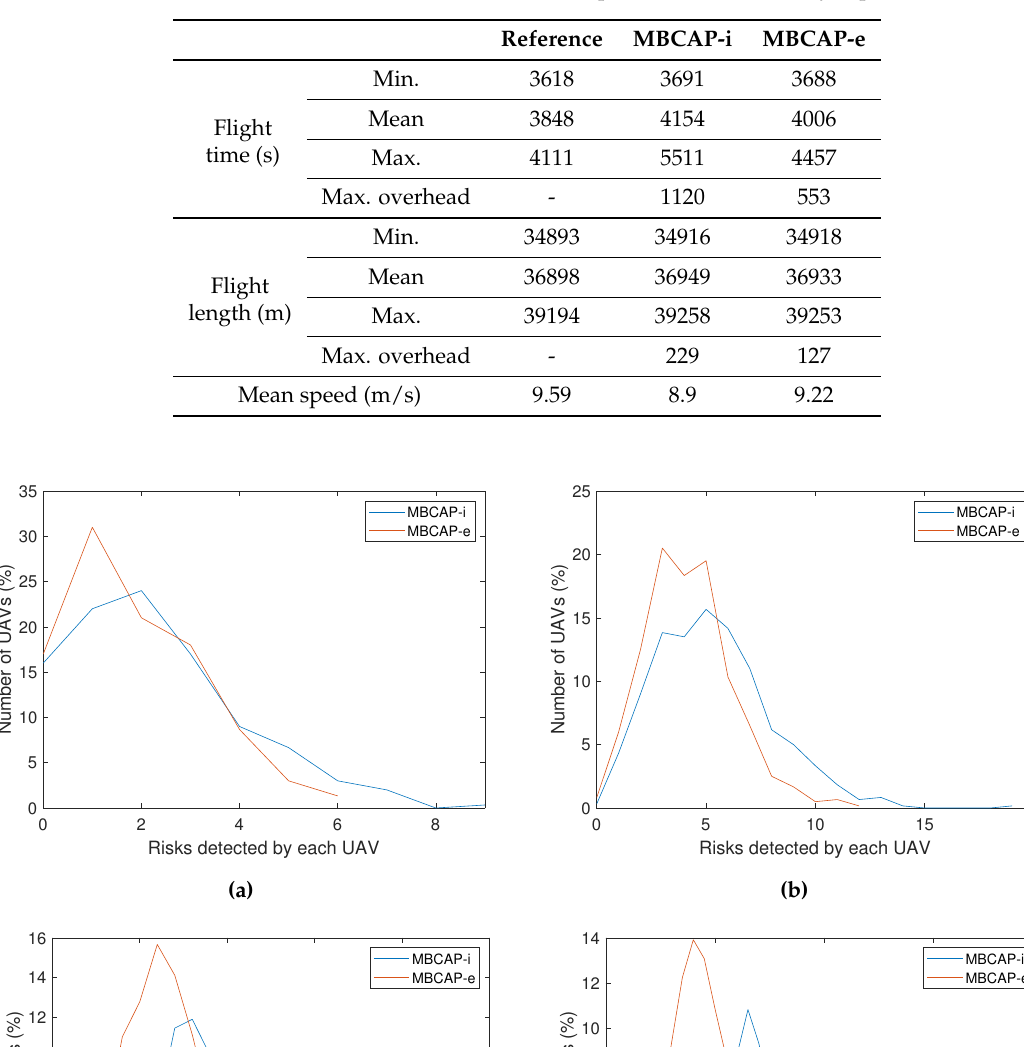
Table 5. MBCAP-i vs. MBCAP-e: Performance comparison (mean value by experiment).